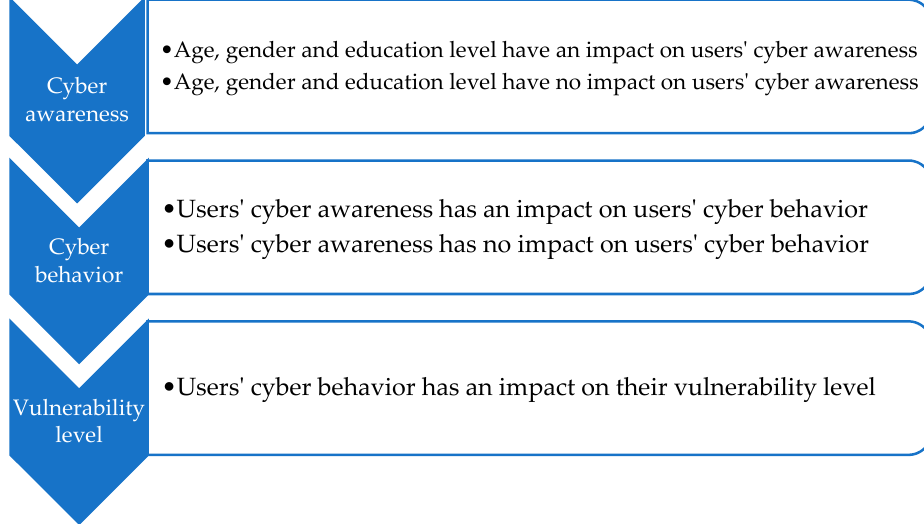
Figure 3. Summary of findings.